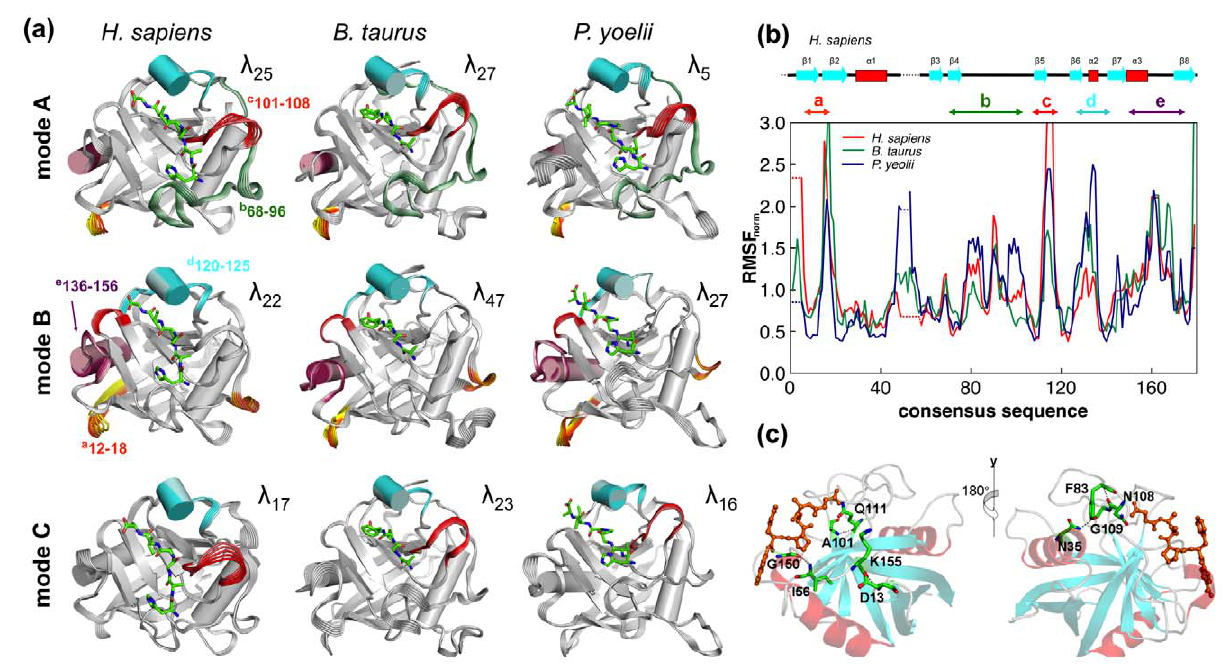
Figure 1. Conservation of reaction-coupled flexibility in enzyme CypA across three different species. (a) Top three slowest modes coupled to the cis/trans isomerization reaction show large fluctuations in identical regions (near and away from the active-site). Multiple snapshots are shown to indicate movements along the modes, and the regions with high flexibility are shown in color. The depicted modes are the ones showing largest coupling to the reaction and are ranked differently from the slowest modes for the entire enzyme–substrate complex ( l N indicates the rank of each mode based on the eigenvalue provided by quasi-harmonic analysis, with l 1 corresponding to slowest mode). (b) Enzyme backbone flexibility depicted as root mean square fluctuations (RMSF); computed by aggregating the C a displacement magnitude in the top 10 modes coupled to the reaction. For comparison, consensus sequence has been used and RMSF has been normalized by dividing by the average C a flexibility of all residues in the enzyme (see Text S2 for the consensus sequences). Also, the regions marked as ‘‘a–e’’ correspond to the colored regions in panel (a) that show the largest displacements in the modes. (c) Conservation of the network interactions connecting the flexible regions as a part of the CypA fold (only human CypA is shown; however, these interactions are conserved in human cyclophilin B, CypA from Brugia malayi , B. taurus , and E. coli as well). See Text S1 and Movies M1-M9 for more details.